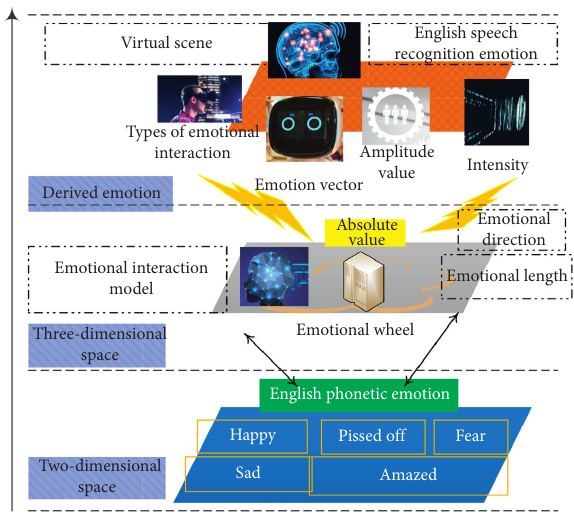
Figure 2: English speech emotion interaction classification